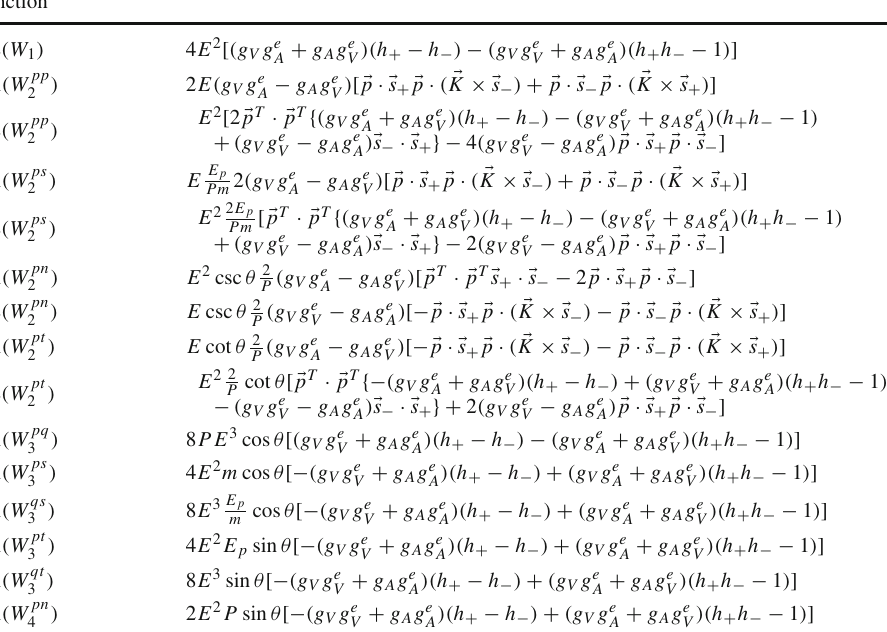
Table 2 As in Table 1, for vector and axial-vector